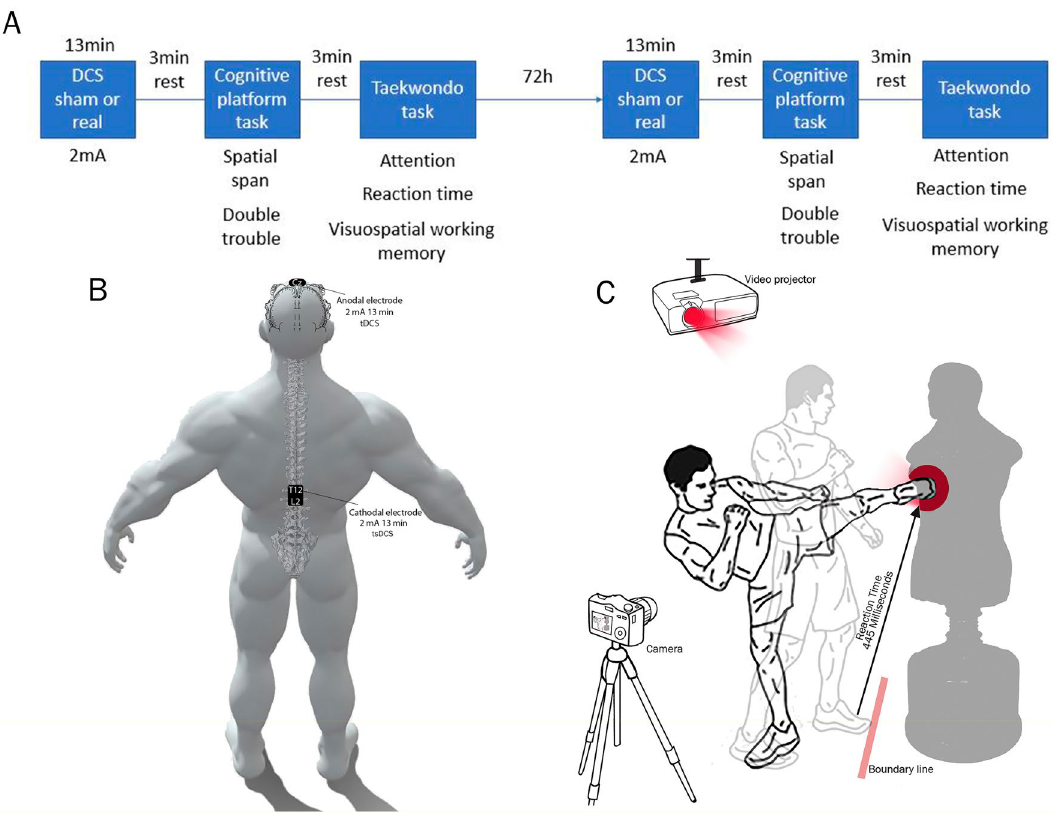
Figure 1. Study protocol, the tDCS + tsDCS montages used for brain stimulation and Taekwondo task. ( A ) Design of the steps and order of the test for study participants. A 3-min rest was considered between the steps. ( B ) Electrodes placement. Anode electrode was placed on the scalp on the primary motor cortex of the lower limb (M1), and the cathode electrode was placed on the skin of the twelfth thoracic to second lumbar vertebrae (T12-L2) on the lumbosacral plexus. ( C ) Design of the motor tests of the participants. The distance between the athletes and the mannequin and its height was adjusted based on the height of the athlete. The motor tests and motor stimuli were shown on the mannequin by the video projector, and reaction time, accuracy, and visual- spatial memory were assessed accordingly. All activities of the athletes during the tests were recorded by a video camera at 240 frames per